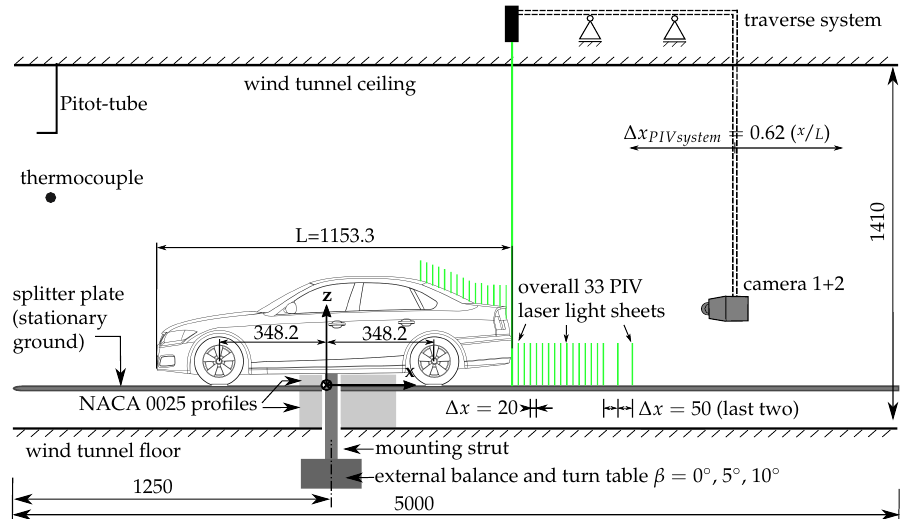
Figure 3. Setup of the wind tunnel: Units are in millimeters.